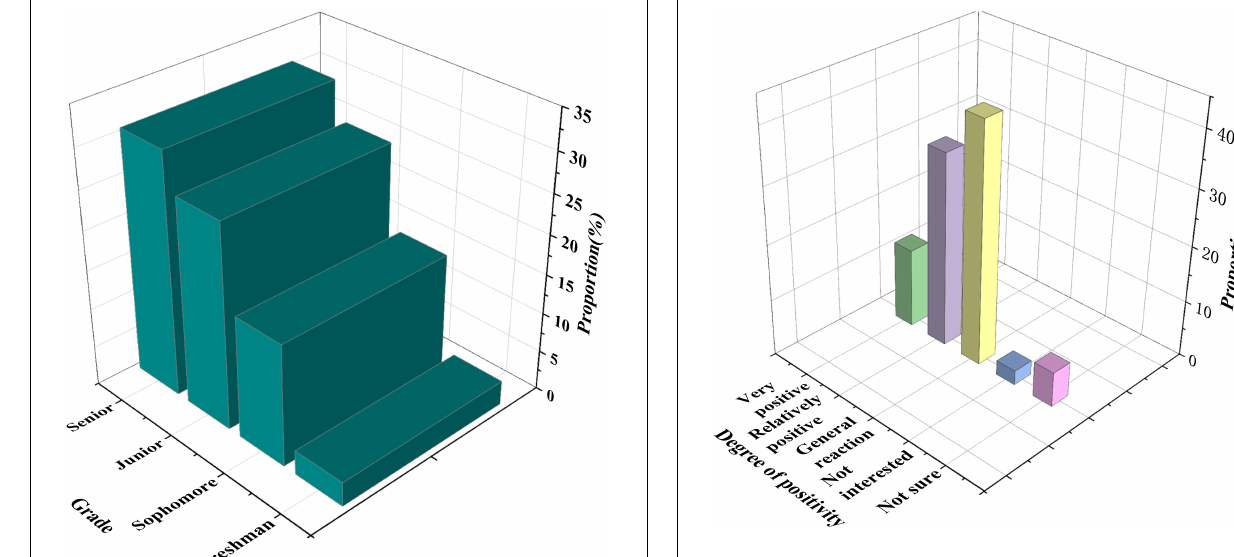
FIGURE 8 | Statistical chart of students’ enthusiasm for entrepreneurship and innovation professional